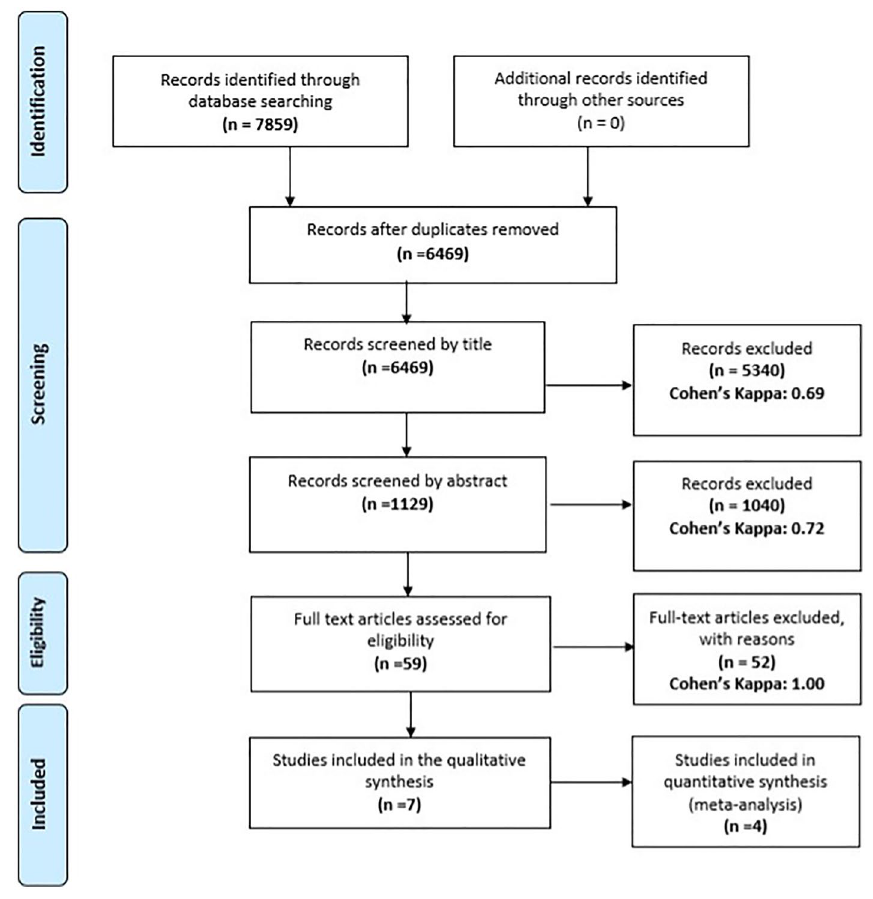
Figure 1. PRISMA (preferred reporting items for systematic reviews and meta-analyses) flowchart showing the different phases of this systematic review and